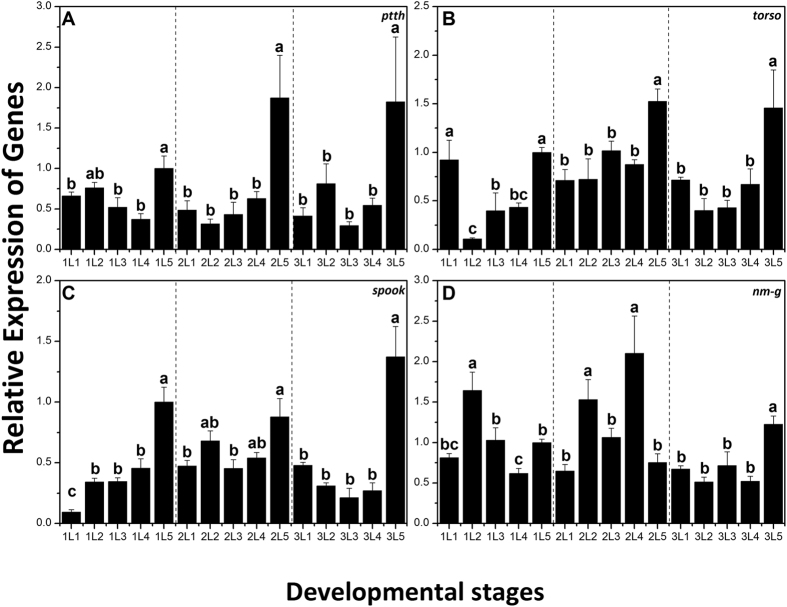
Relative expression levels of ptth (A), torso (B), spook (C), nm-g (D) for different differential stages of Chilo suppressalis.Expression levels at 15 different time points in first-instar and second-instar larvae were detected by q-PCR. Different letter shows significant difference (P < 0.05, ANOVA).